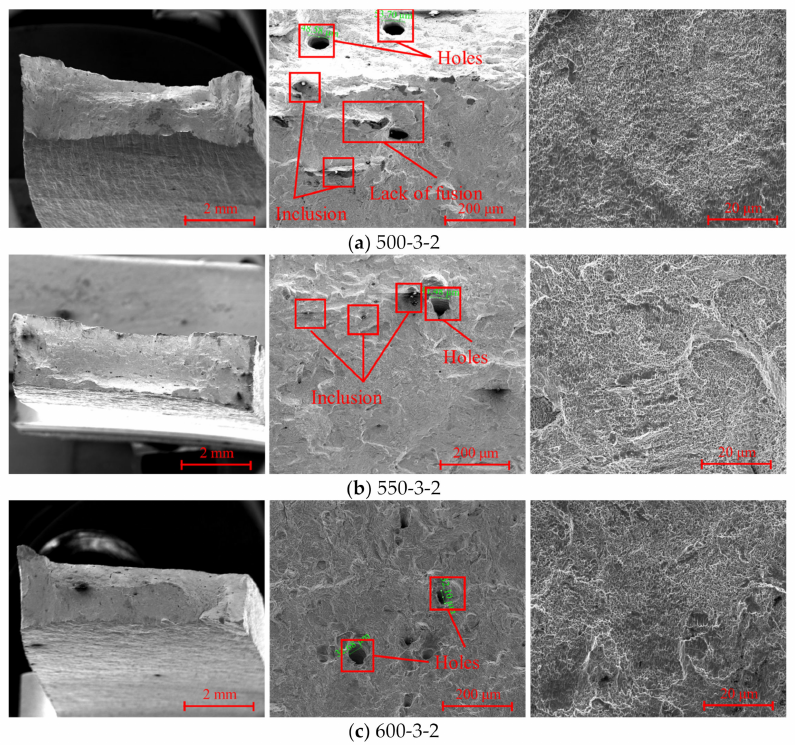
Figure 11. Fractography of the SLM in the uniaxial tensile samples fabricated under different shielding gas volume flows after tensile